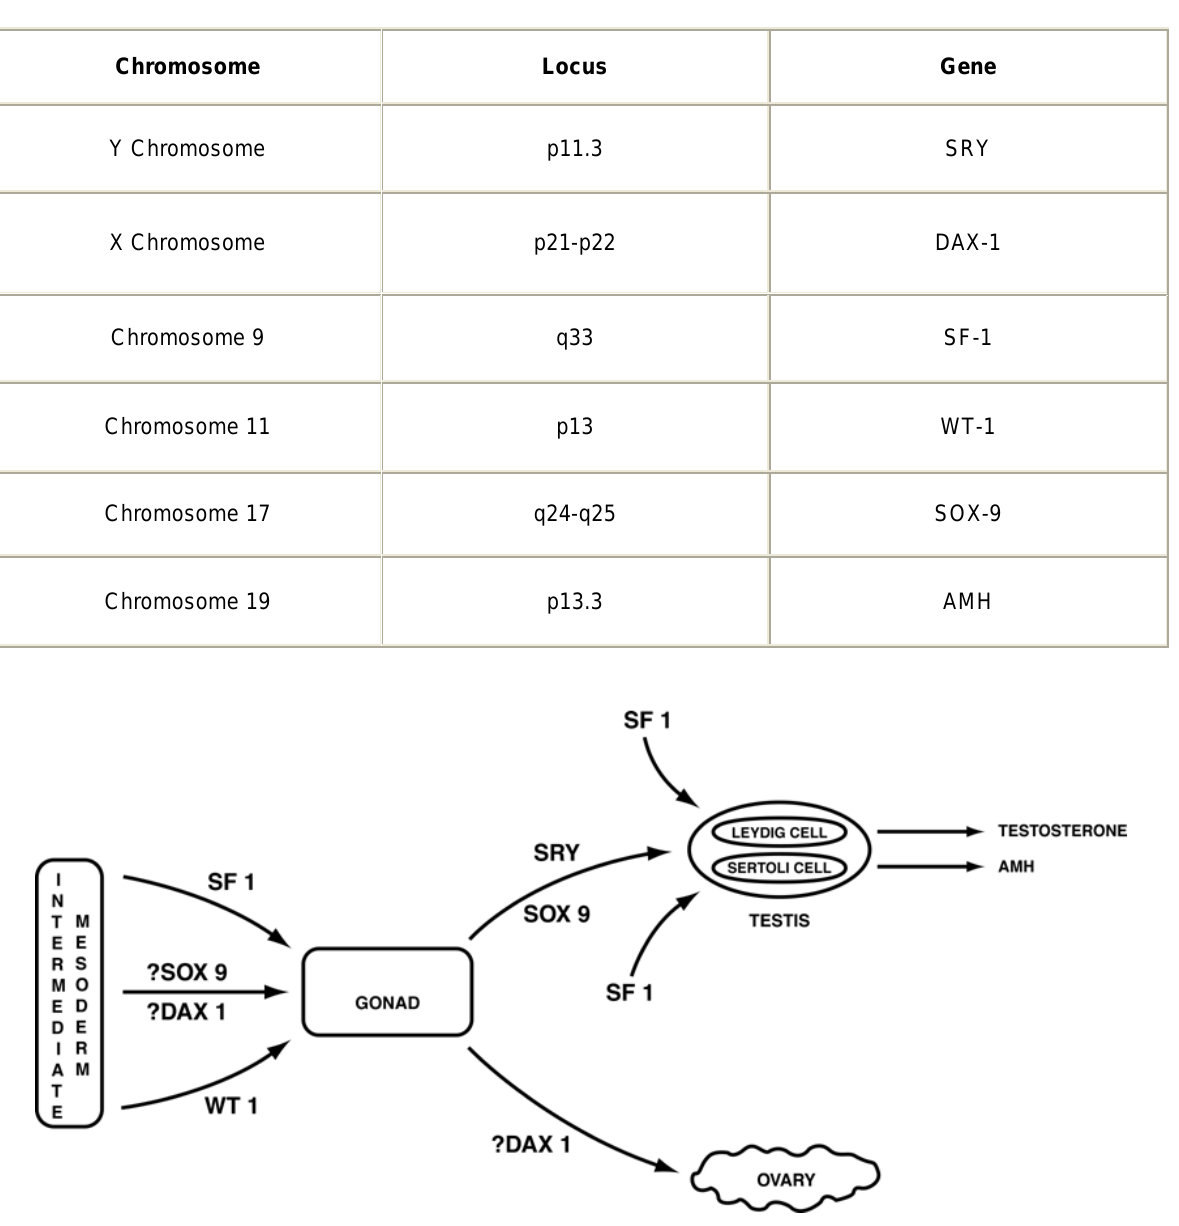
Known or candidate genes in the testicular developmental cascade.